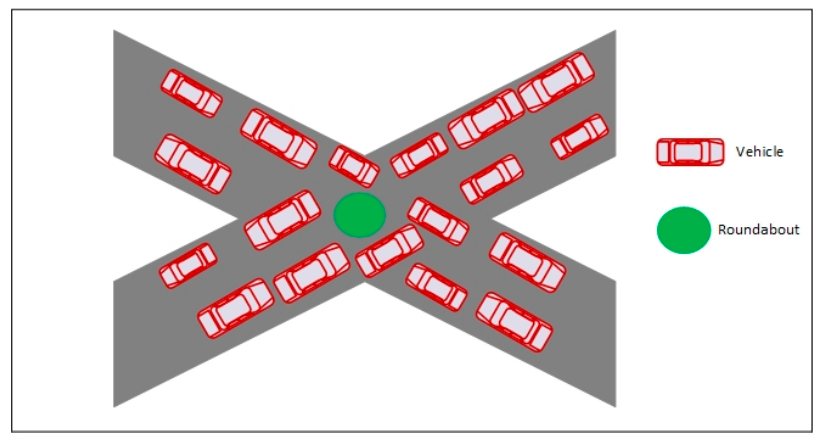
Figure 1. Scenario without intelligent transport system.